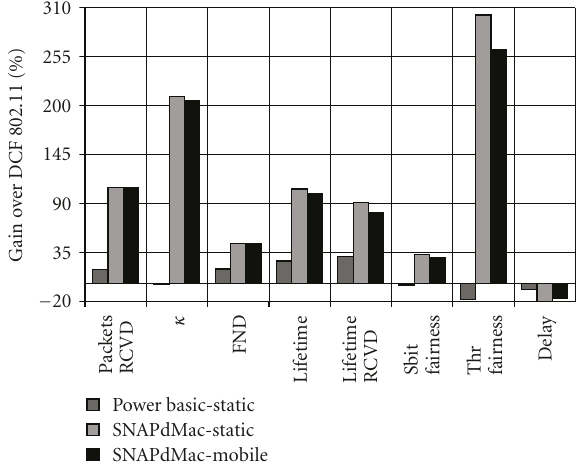
Figure 6: General results, 50 static and mobile